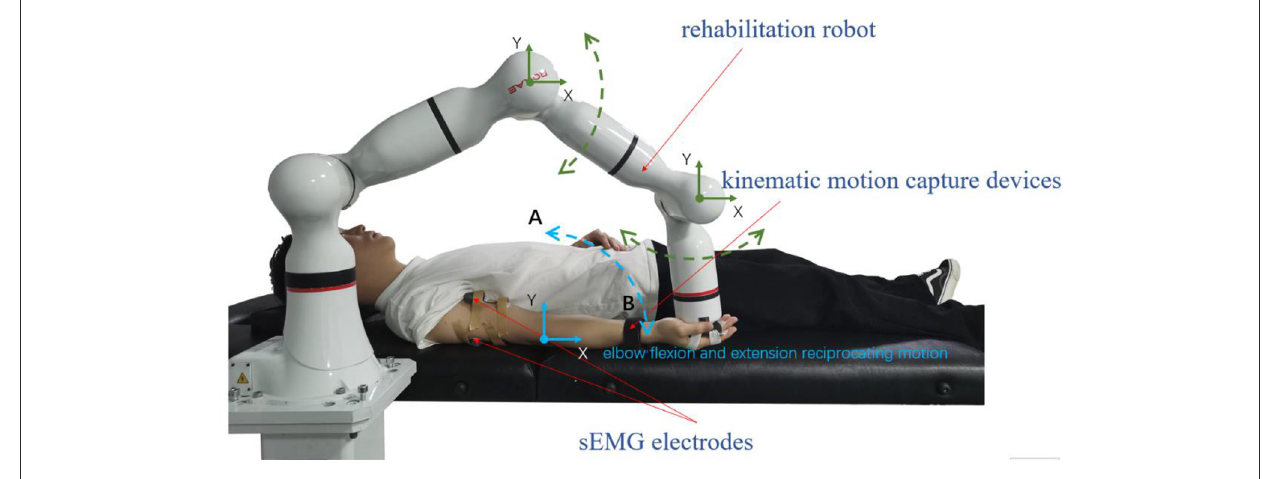
FIGURE2 The experiment installation of the rehabilitation